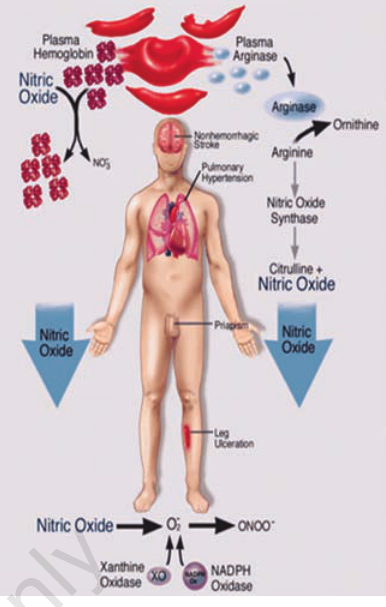
Figure 6. Depletion of nitric oxide in sickle cell anemia. 29 Legend: Sickle cell disease Hemolysis Arginine Ø NO Ø . During intravascular hemolysis, hemoglobin is released into the plasma where it is normal- ly cleared by the hemoglobin scavengers haptoglobin, CD163, and hemopexin. Haptoglobin-hemoglobin complexes bind to CD163 on the surface of macrophages/ monocytes initiating endocytosis and degradation of the complex. Hemoglobin also releases ferric heme on oxidation, which is bound by hemopexin and degrad- ed by hepatocytes in the liver. Excessive hemolysis saturates and depletes these hemoglobin removal systems and leads to a build-up of hemoglobin and heme in the plasma. Plasma hemoglobin and heme mediate direct proinflammatory, prolifera- tive, and pro-oxidant effects on vessel endothelial cells. NO is normally generated from L-arginine in vessel endothelial cells by the enzyme nitric oxide synthase (NOS). NO maintains smooth muscle relaxation and inhibits platelet activation and aggre- gation, thereby regulating vessel tone and promoting organ system homeostasis. During intravascular hemolysis, NO avail- ability can be severely limited by its reac- tion with oxyhemoglobin (NO scavenging) and by the breakdown of the substrate for NO synthesis, L-arginine, by the red cell enzyme arginase, despite elevated levels of NOS (decreased NO synthesis). NO deple- tion results in decreased activation of guanylate cyclase, an enzyme required for the generation of cyclic guanine mono- phosphate (cGMP). Decreased cGMP lev- els disrupt regulation of smooth muscle tone resulting in dystonias, including sys- temic and pulmonary hypertension, erec- tile dysfunction, dysphagia, and abdominal pain. Decreased cGMP levels through the depletion of NO can also lead to platelet activation and aggregation, promoting clot formation. GTP indicates guanosine 5’- triphosphate. (Modified from JAMA